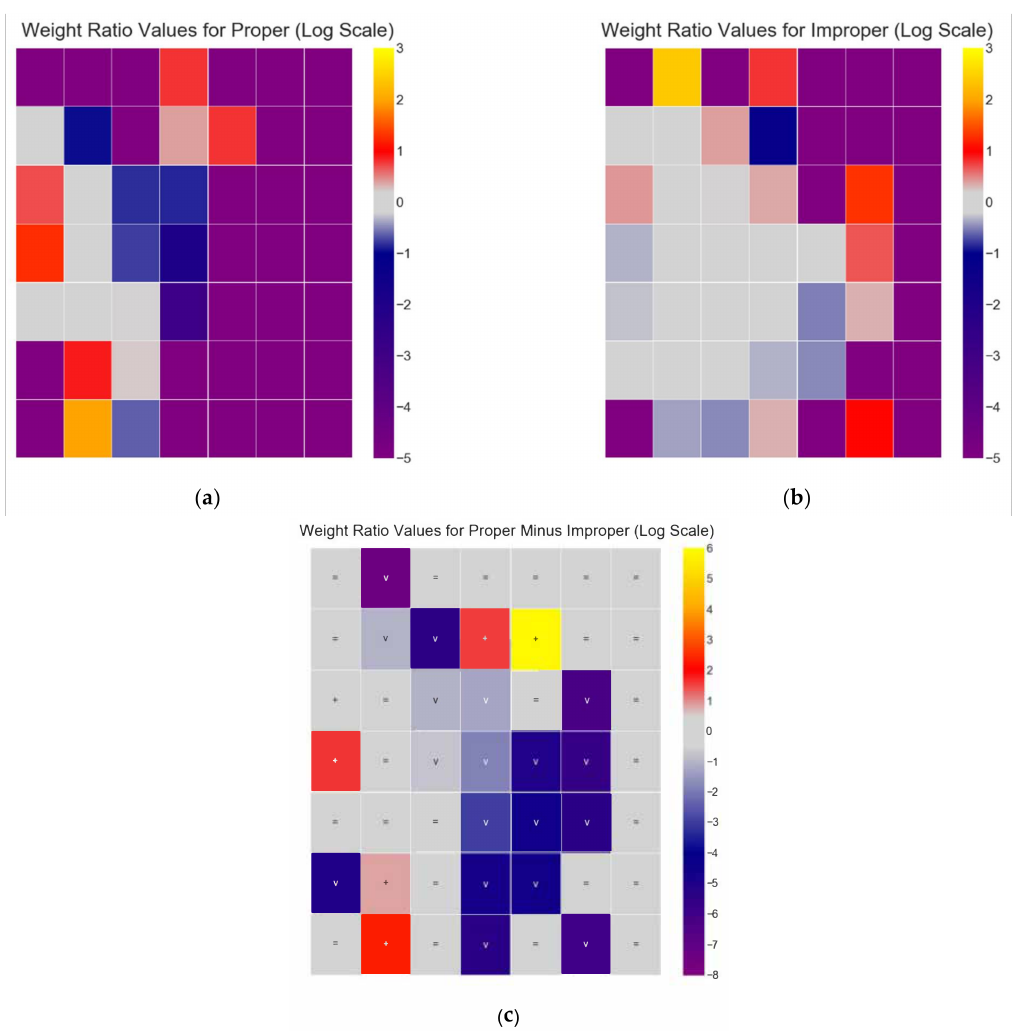
Figure 5. Heat maps for the log-transformed weight ratio values generated using two-dimensional histograms for ( a ) Proper (log(proper + ε )) and ( b ) Improper (log(improper + ε )) ( ε = 1.0 × 10 − 5 ) methods of dataset partitioning for spectral features of the Driver Fatigue dataset [33]. Graph ( c ) depicts the difference in log-transformed weight ratio values between the proper and improper methods (log(proper + ε )—(log(improper + ε )), with labels for each bin indicating approximately equal weights (=), a significant negative delta (v), or a significant positive delta (+). These heat maps are newly generated from the data obtained in the Driver Fatigue dataset